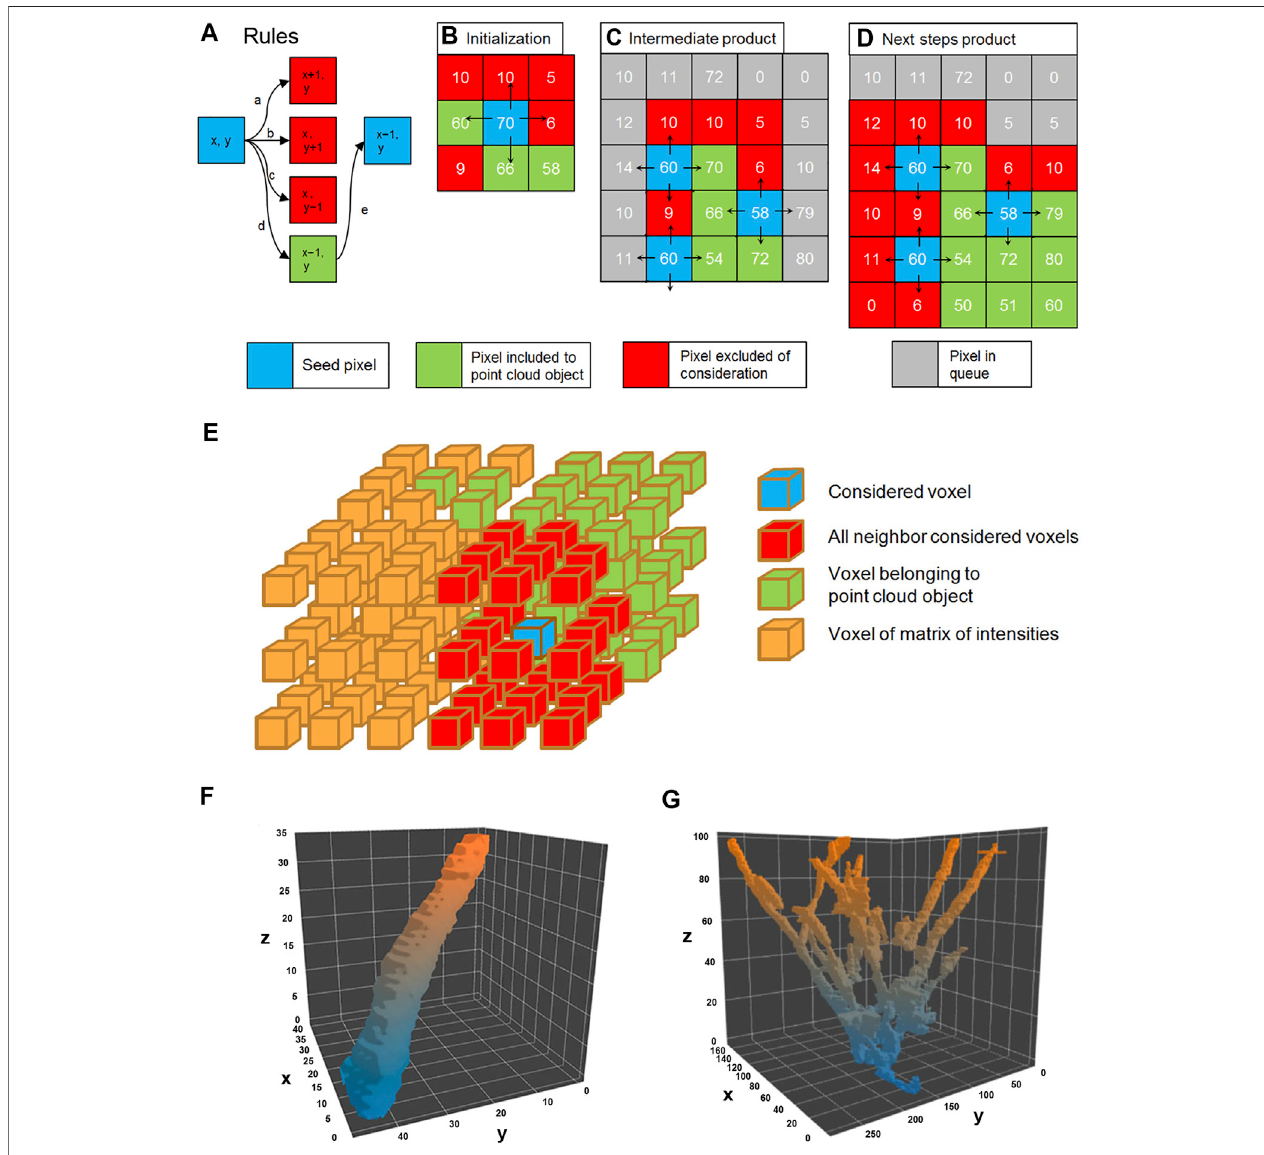
FIGURE 2 | Flood fi ll algorithm procedure rules (A) . The only pixel which satis fi es the rule (marked green) is chosen as seed to the next step marked green. The initialization of fl ood fi ll by seed pixel (B) ; in the consecutive steps (C) and (D) fl ood fi ll a search for other pixels satisfying the rules. The 3D representation of the fl ood fi ll algorithm (E) . The result is 3D visualization of the plus end comet in the spatial – temporal domain (F) . A pillar represents the trajectory of the segmented growing single microtubule, and the Z domain is time. The multitude of growing microtubules forms an object point cloud where comets form a tree shape, where comets ’ tracks may overlap (G)